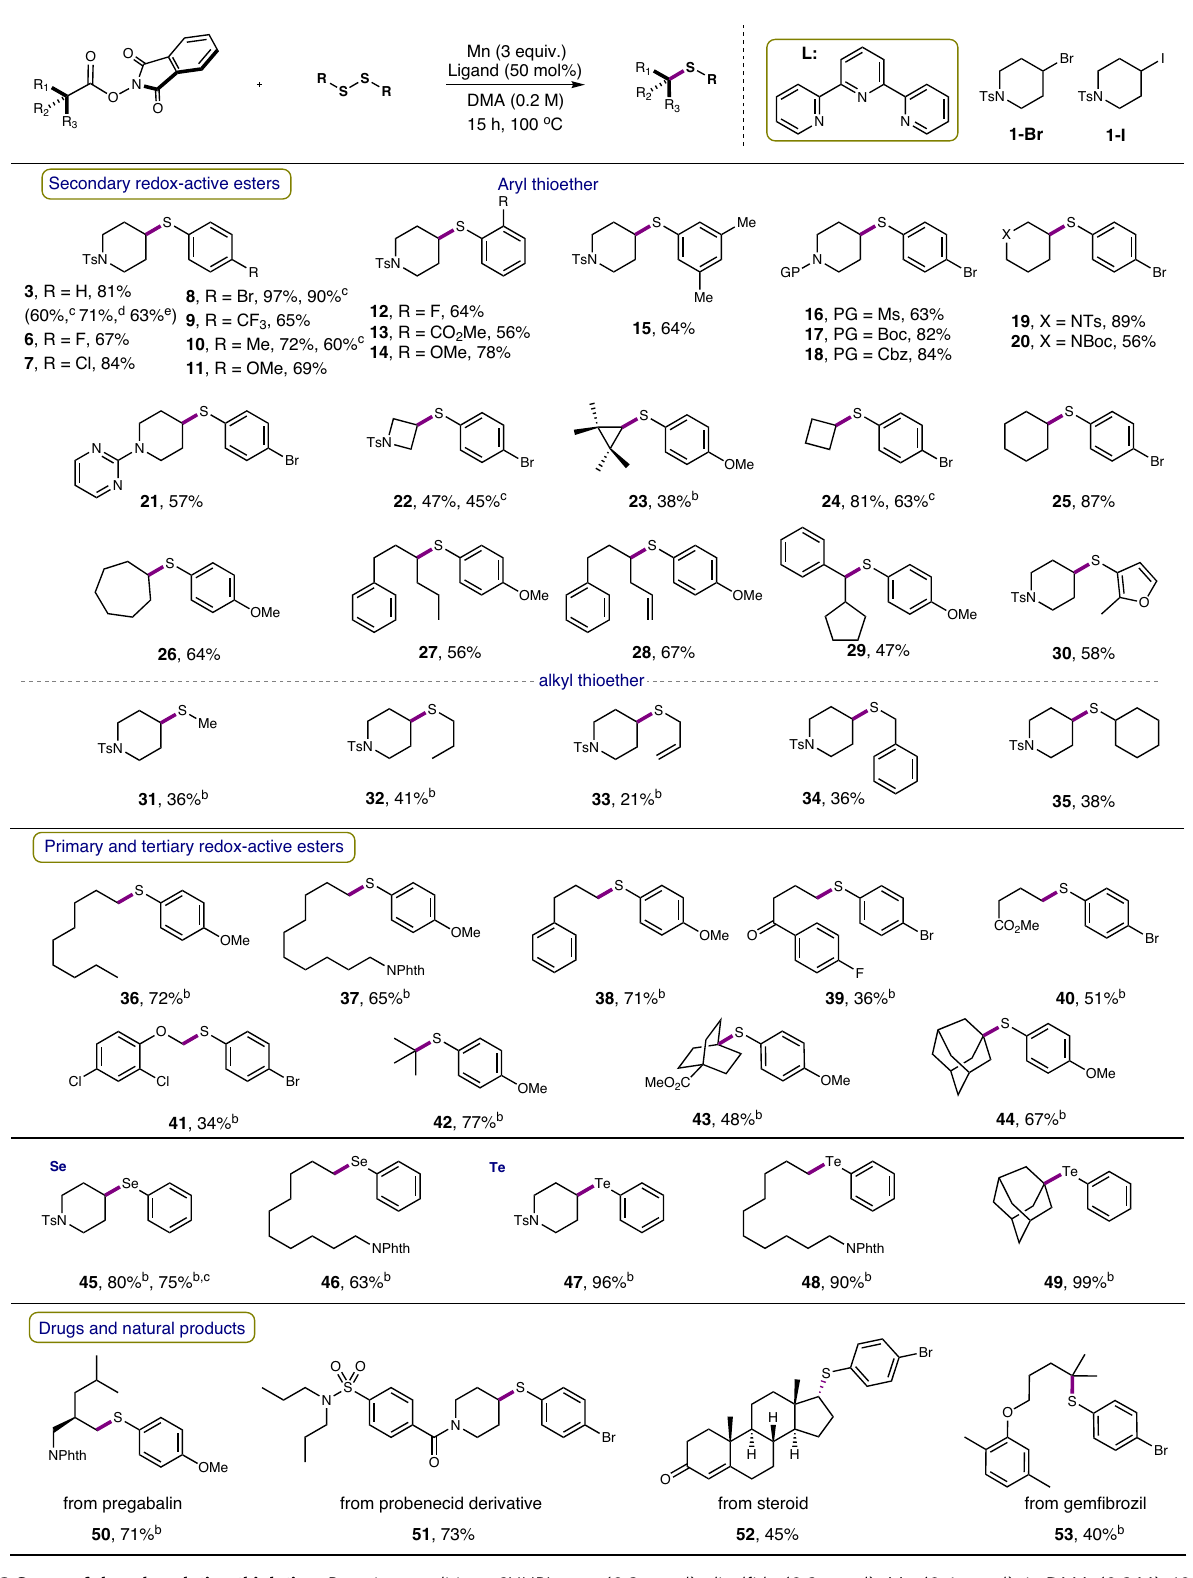
Fig. 3 Scope of decarboxylative thiolation. Reaction conditions. a NHPI ester (0.3 mmol), disul fi de (0.2 mmol), Mn (0.6 mmol), in DMA (0.2 M), 100 °C, N 2 , 15 h; yields are for isolated products. b NHPI ester (0.4 mmol). c Without ligand. d 1-Br was used. e 1-I was